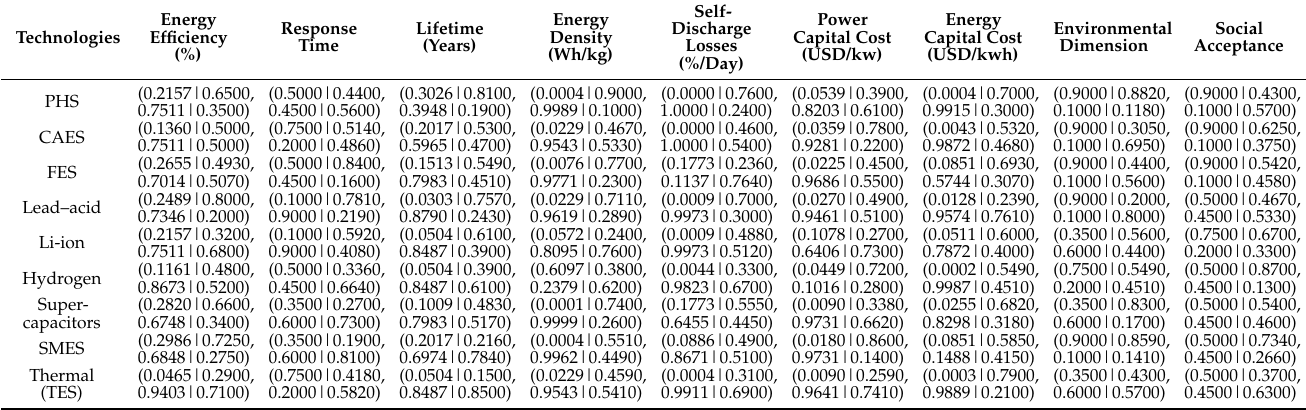
Table 6. Initial decision matrix of Expert